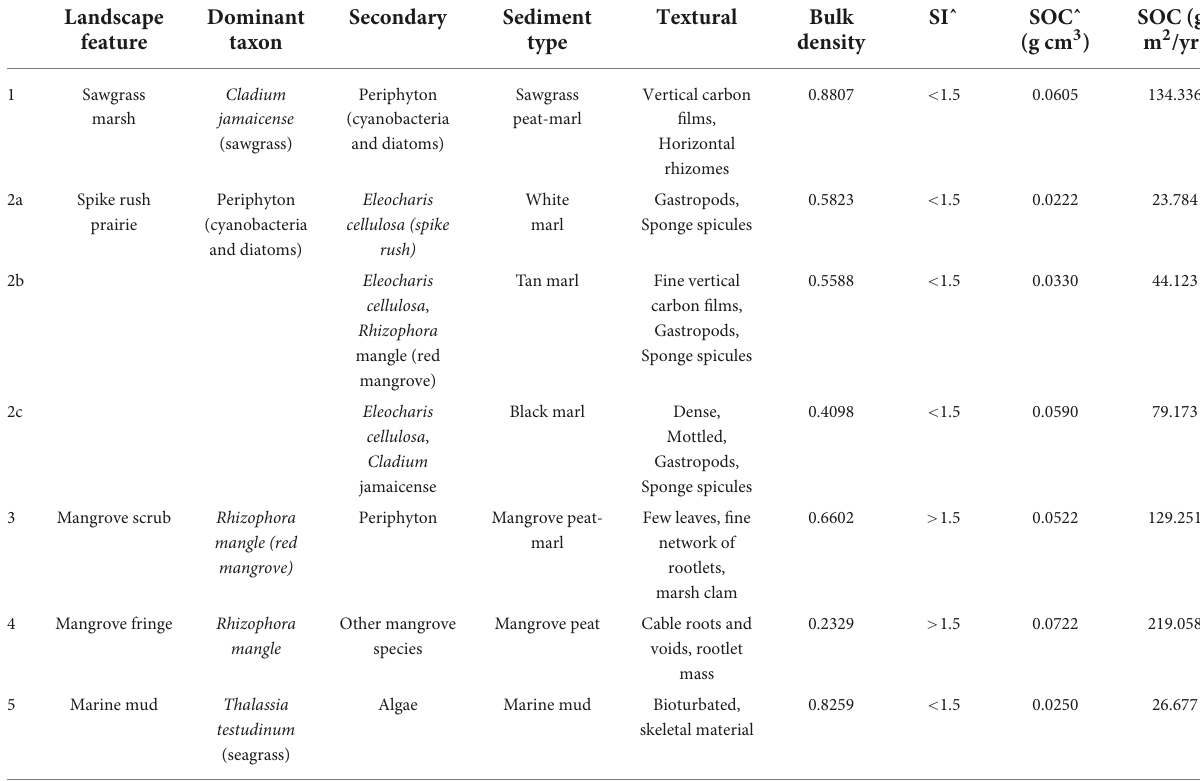
TABLE 3 Summary of facies characteristics (modified from Meeder et al.,